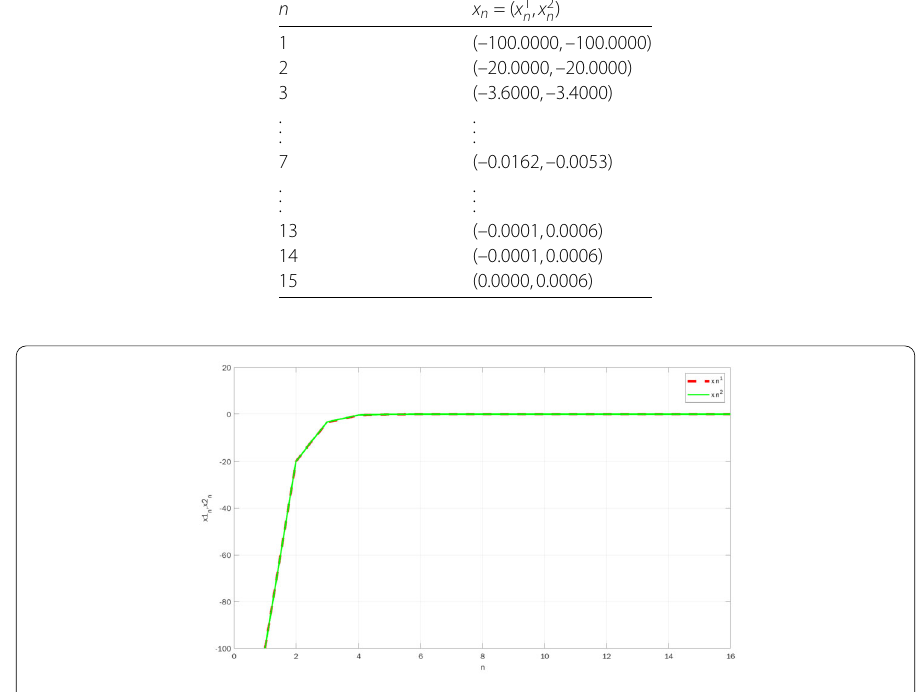
Figure 1 The convergence of { x n } with x 1 = (–100,–100) and n = N =